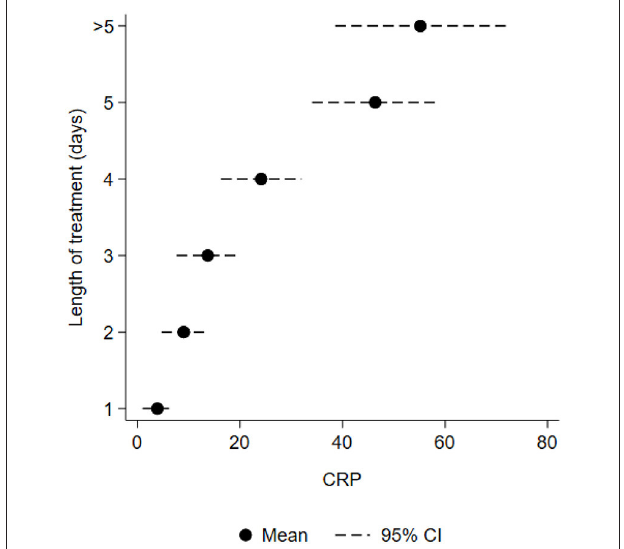
FIGURE 2 | Mean maximum CRP level ( n = 120) in relation to number of treatment days (GA ≥ 28 weeks) among Norwegian hospitalized